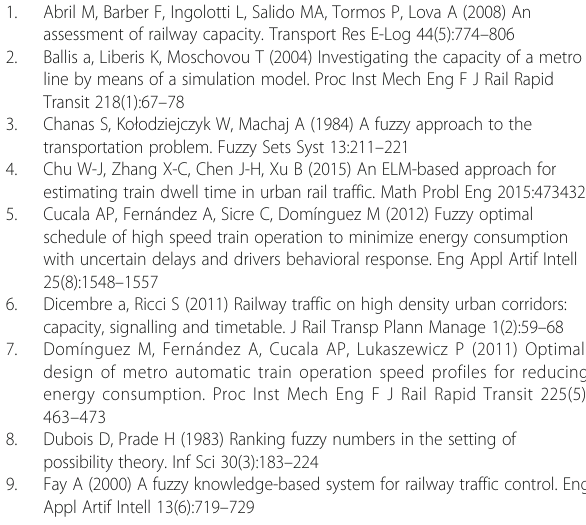
table compression method to obtain minimum conflict-free cycle times of the section under study.